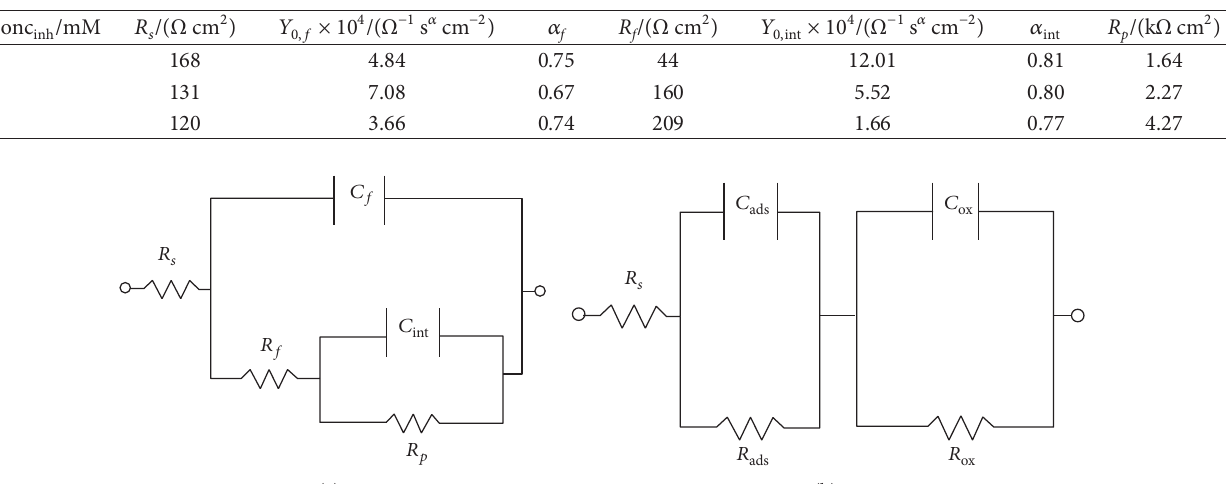
Table 1: Parameters from equivalent circuit analysis of typical impedance data obtained in the blank and solutions containing glutarate with low concentrations (1mM and 5 mM).